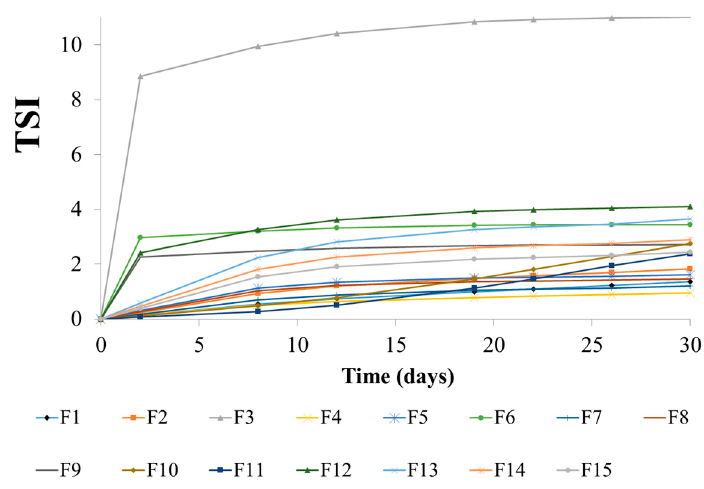
Figure 5. TSI values for the prepared emulsions during storage period.